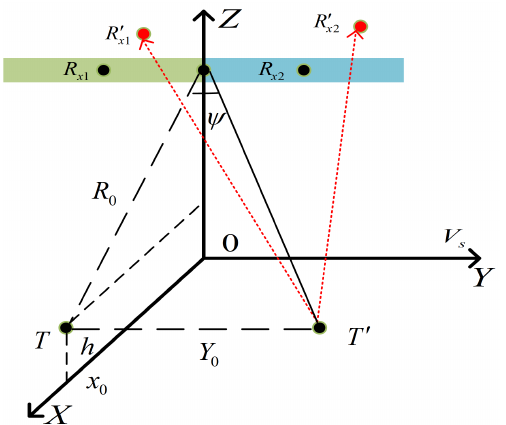
Figure 2. The geometric model with baseline error under the condition of squint